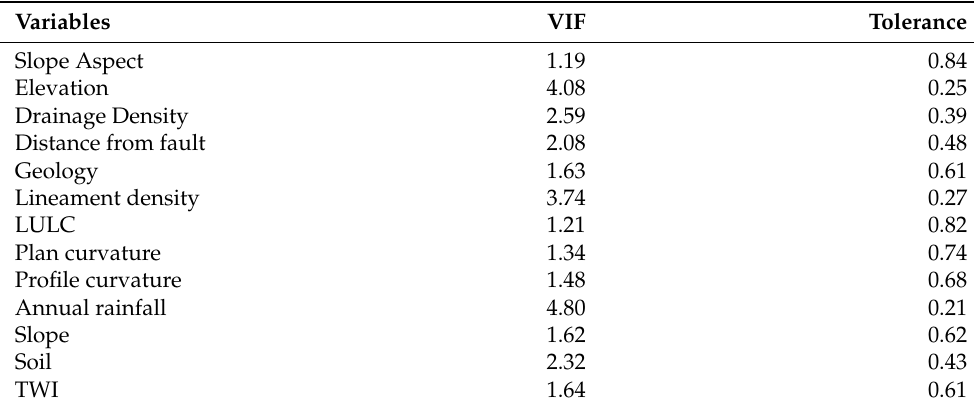
Table 1. The multicollinearity evaluation of thirteen independent variables.